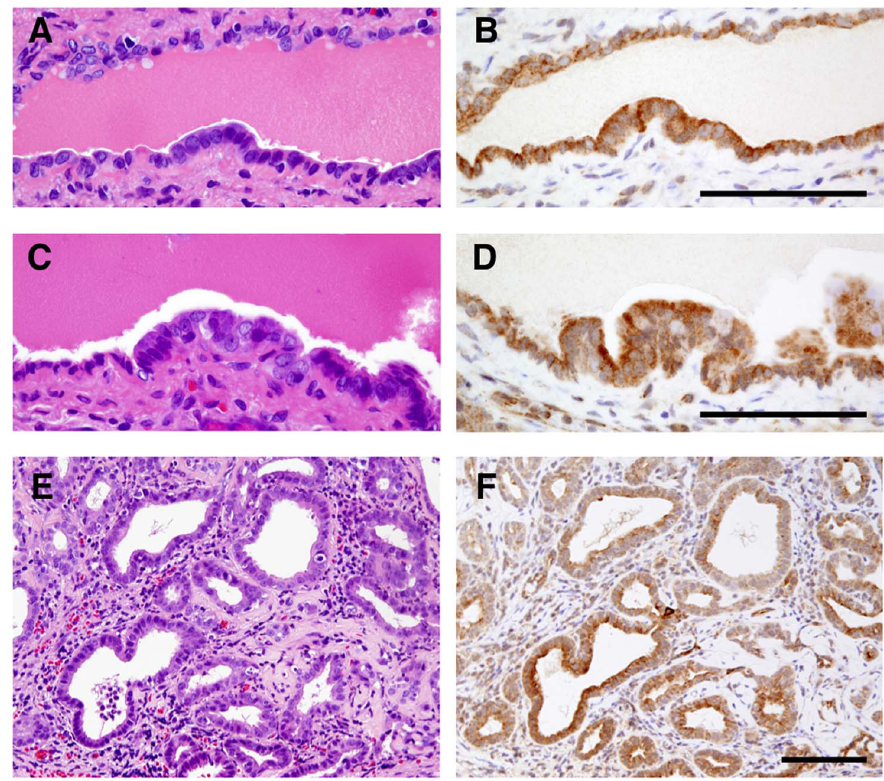
Figure 3. Expression of ERC/mesothelin in pancreatic lesions. Immunostaining of ERC/mesothelin in PanIN1 (A and B), PanIN2 (C and D) and PDA (E and F) lesions. A, C, E, H&E staining; B, D, F, ERC/mesothelin staining. Bars=100 m m. doi:10.1371/journal.pone.0111481.g003 Serum test The serum level of rat N-ERC/mesothelin was quantified by ELISA (Code No.27765, Rat N-ERC/mesothelin Assay Kit, IBL, Gunma, Japan) as described previously [25].